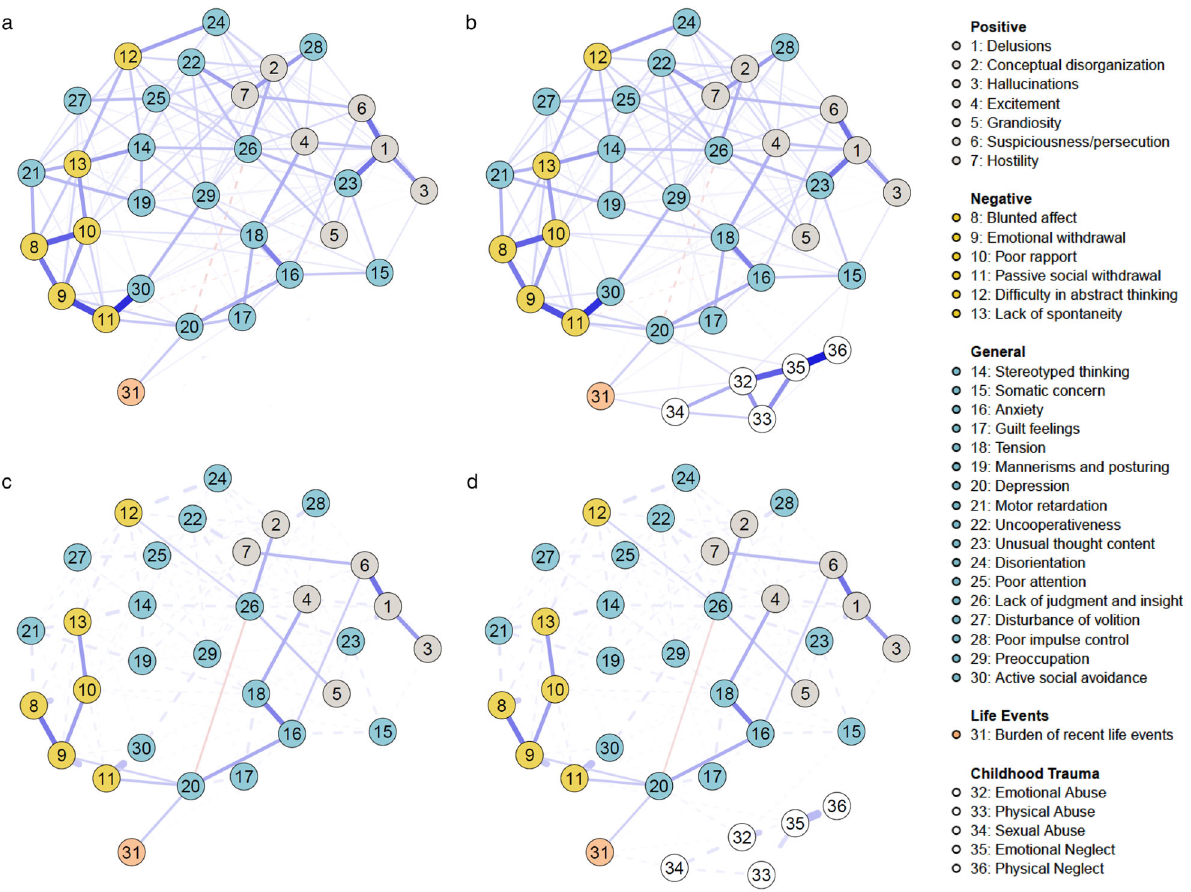
Fig. 1 Cross-sectional network of relationships between burden of recent life events and symptomatology assessed with the Positive and Negative Syndrome Scale (PANSS 34 ) in the early psychosis spectrum ( n = 547). Upper panel: Network depicting unique associations between burden of recent life events and individual symptoms. a before and b after controlling for different childhood trauma types as covariates. The wider the edge, the stronger the association. Blue (red) edges re fl ect positive (negative) connections. Lower panel: Network highlighting shortest paths between burden of recent life events and the positive and negative symptom domain of the PANSS. c before and d after controlling for different childhood trauma types as covariates. Solid lines represent shortest paths, dashed lines represent connections that do not lie on the shortest paths. The wider the edge, the stronger the association. Blue (red) edges re fl ect positive (negative)